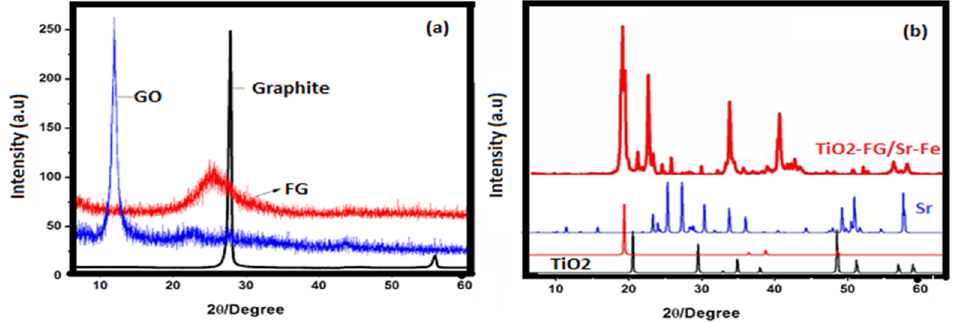
Figure 1. ( a ) XRD pattern of graphene oxide, graphite, and FG. ( b ) TiO 2 , Sr ‐ hexaferrites, and TiO 2 ‐ FG/Sr ‐ hexaferrites.